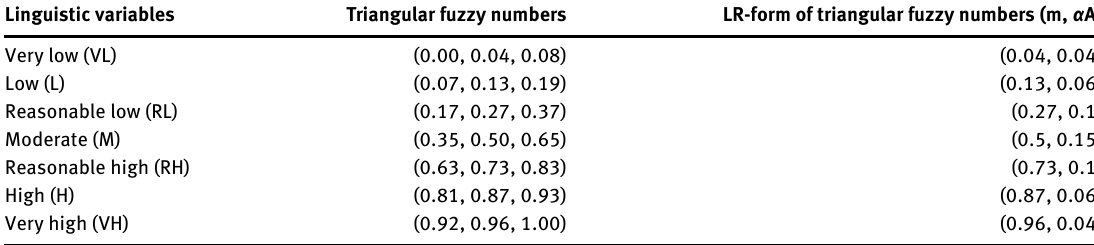
Table 7: Linguistic terms with Conversion Scales [36,